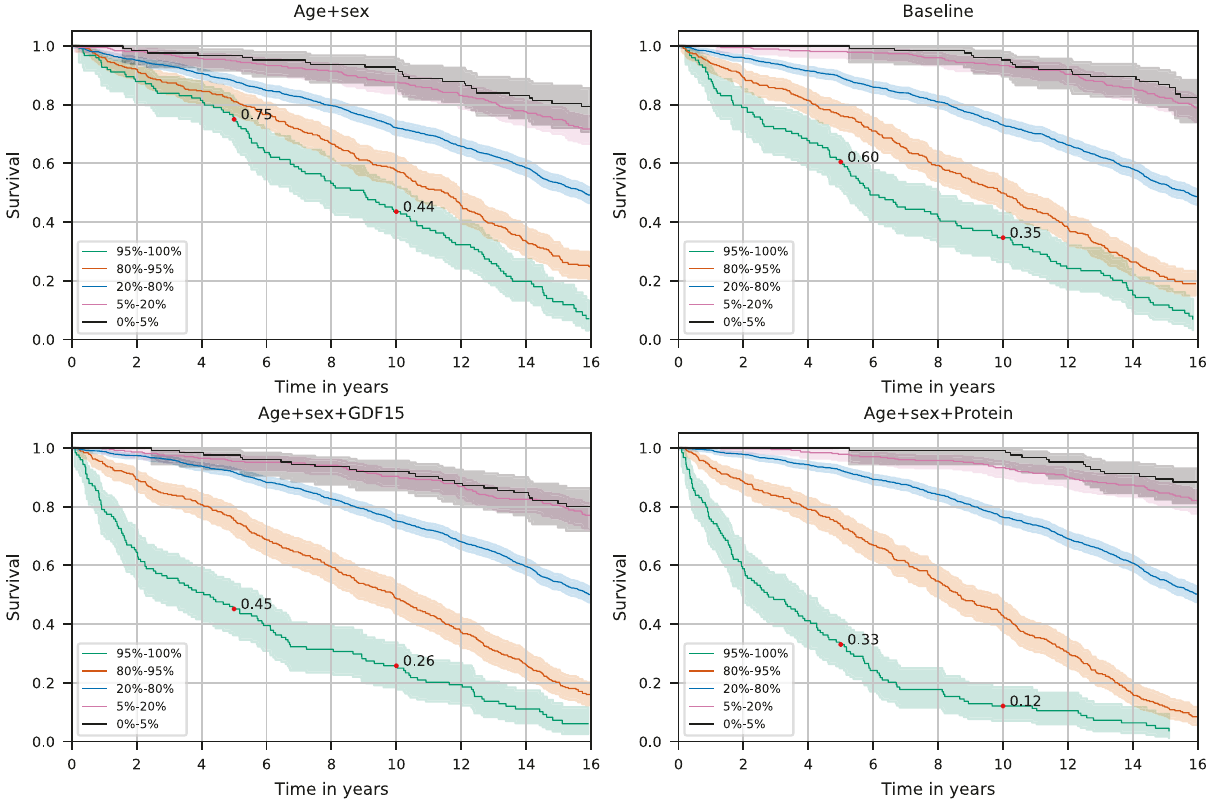
Fig. 2 Survival of 60 – 80 years old participants. The Kaplan – Meier curves for 2488 participants are split by quantiles of predicted 10-year risk by each model, demonstrating the different survival rates in the different risk groups. The colored areas represent 95% con fi dence intervals. The red dots show survival after 5 and 10 years.